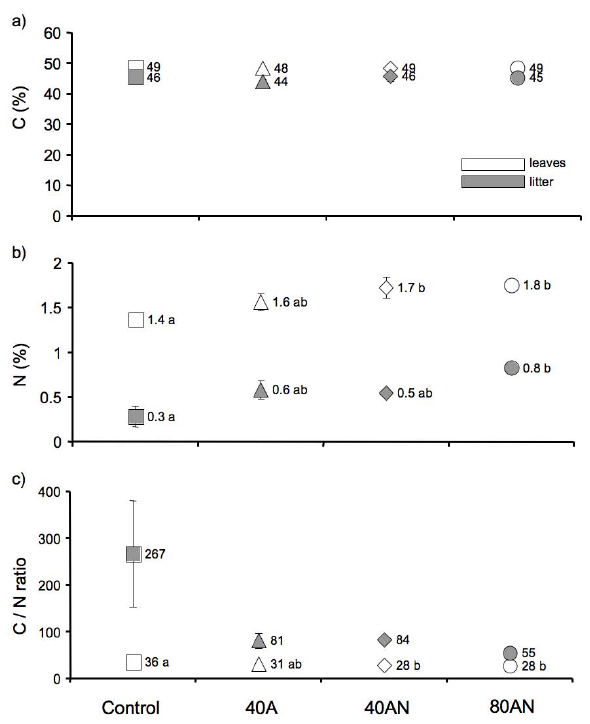
Fig. 3. C and N concentrations and the C/N ratio of leaves and leaf litter of C. ladanifer in response to the distinct N additions (Control, 40A, 40AN and 80AN). Different letters refers to statistically sig- nificant differences between treatments (ANOVA p < 0.05 followed by a Bonferroni test). Symbols and values represent the mean ( n =3 experimental plots per treatment) ± SE.